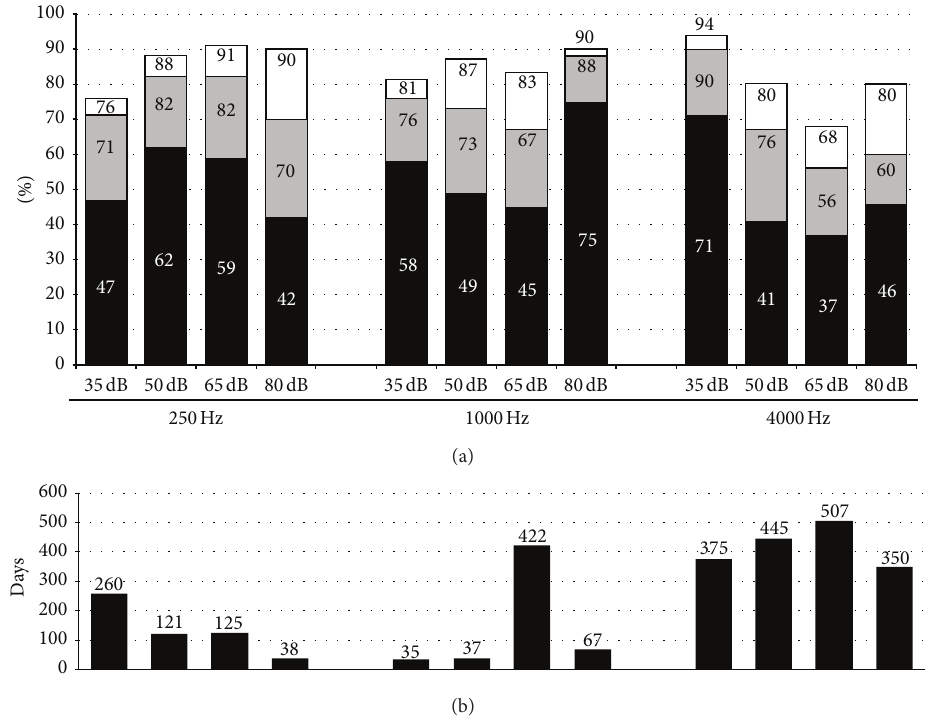
Figure 2: The figure shows the results for Loudness Scaling at 250, 1000, and 4000 Hz. See Figure 1 for